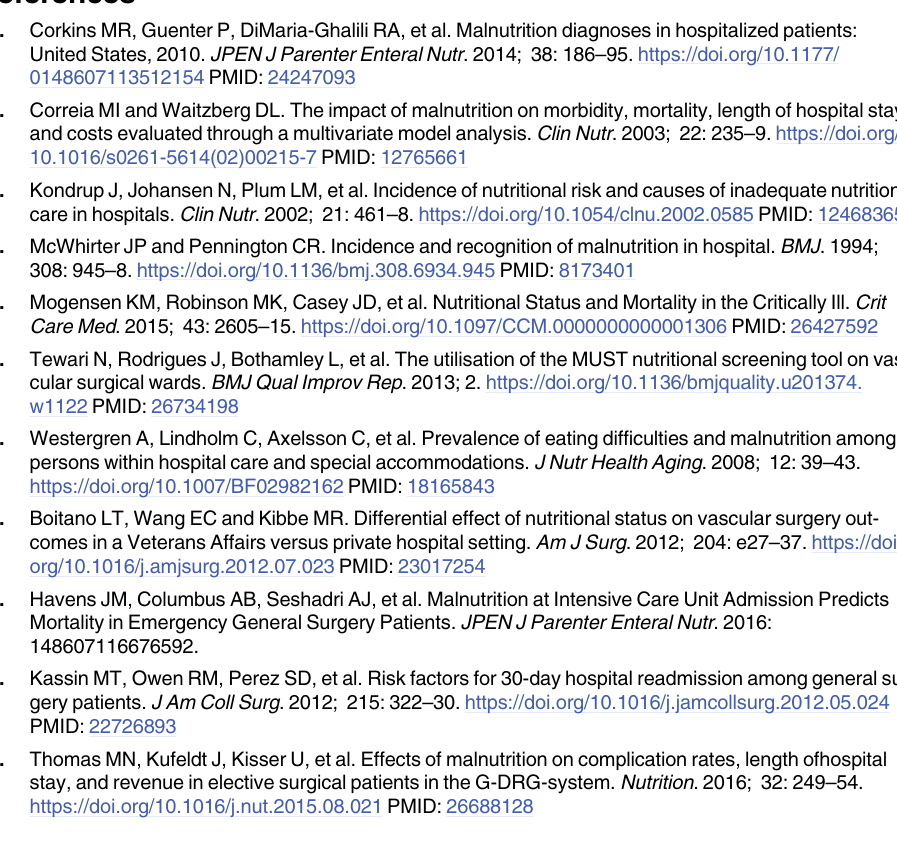
S1 Table. Characteristics of vascular surgery procedure code categories stratified by 90-day post discharge mortality in the analytic cohort (n = 4432). S2 Table. Characteristics of vascular surgery procedure code categories stratified by nutri- tional status in the analytic cohort (n =